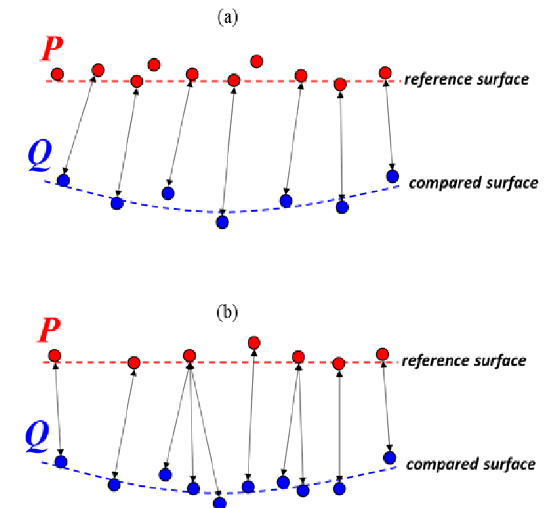
Figure 5. Comparison of nearest neighbor correspondences under differing point cloud densities. In ( a ), the reference point cloud has a higher density than the compared point cloud. The figure in ( b ) is the opposite.